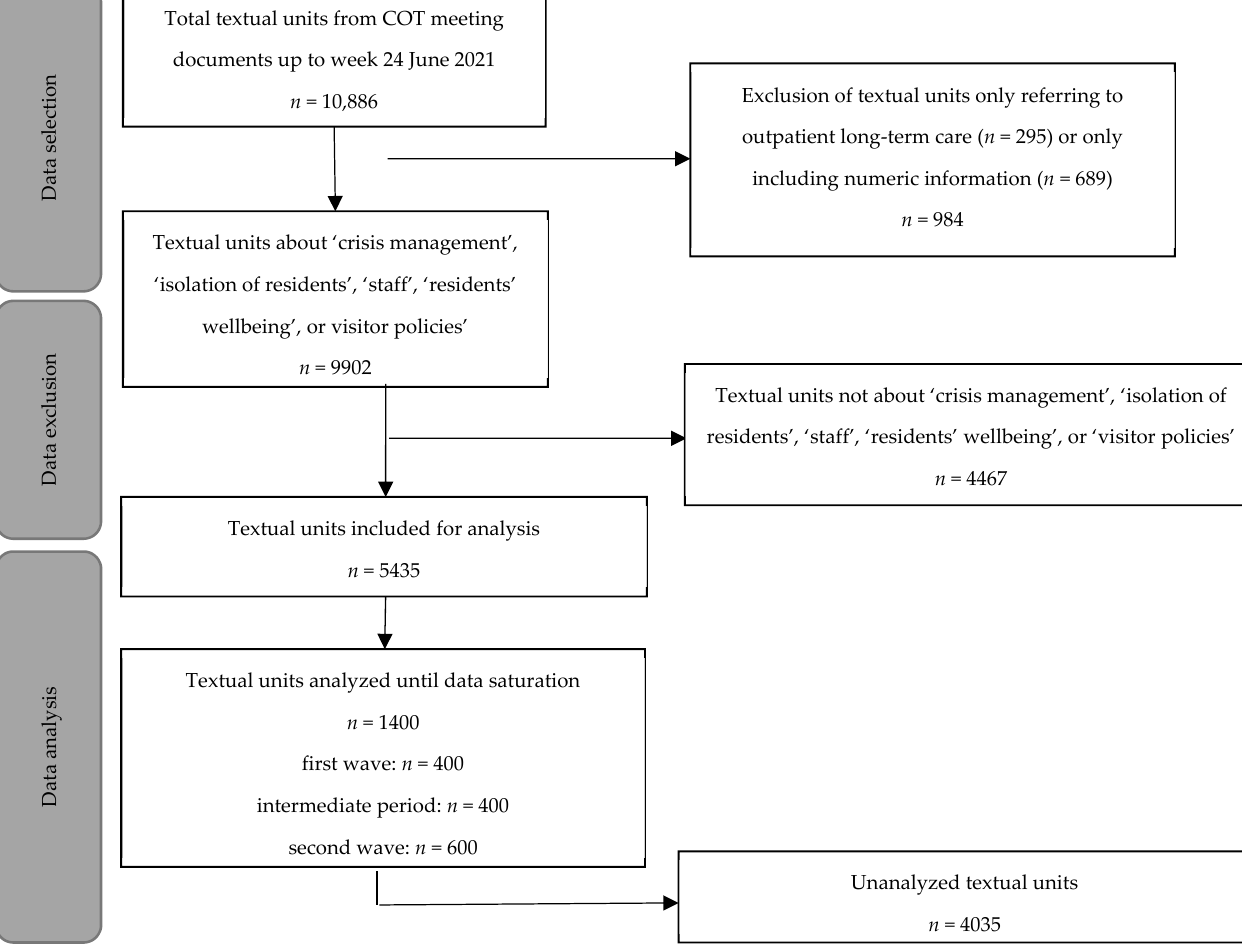
Figure 1. Flowchart of data selection, exclusion, and analysis.